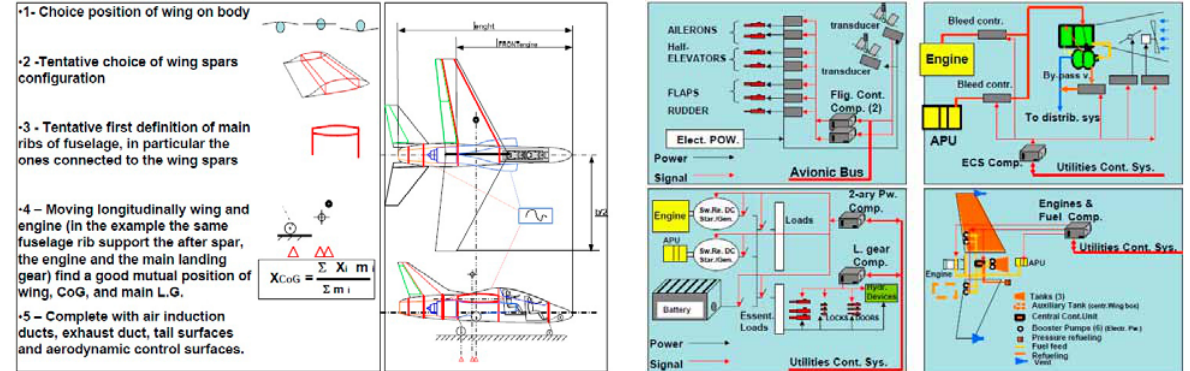
Fig. 13. Preliminary (layout level) systems definitionFig. 12. Wing/fuselage assembly, rib and spars definition, LNDG